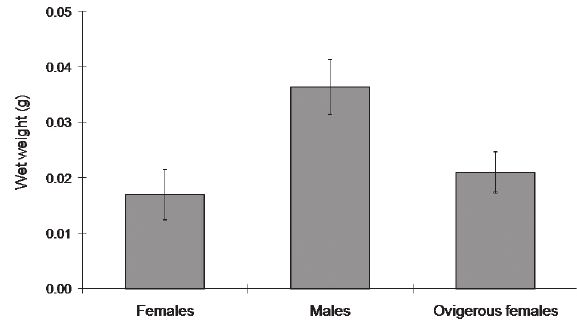
Fig . 3. – overall wet weight of males, females, and ovigerous fe- males occupying different types of shells all along the intertidal. mean and standard errors are shown.